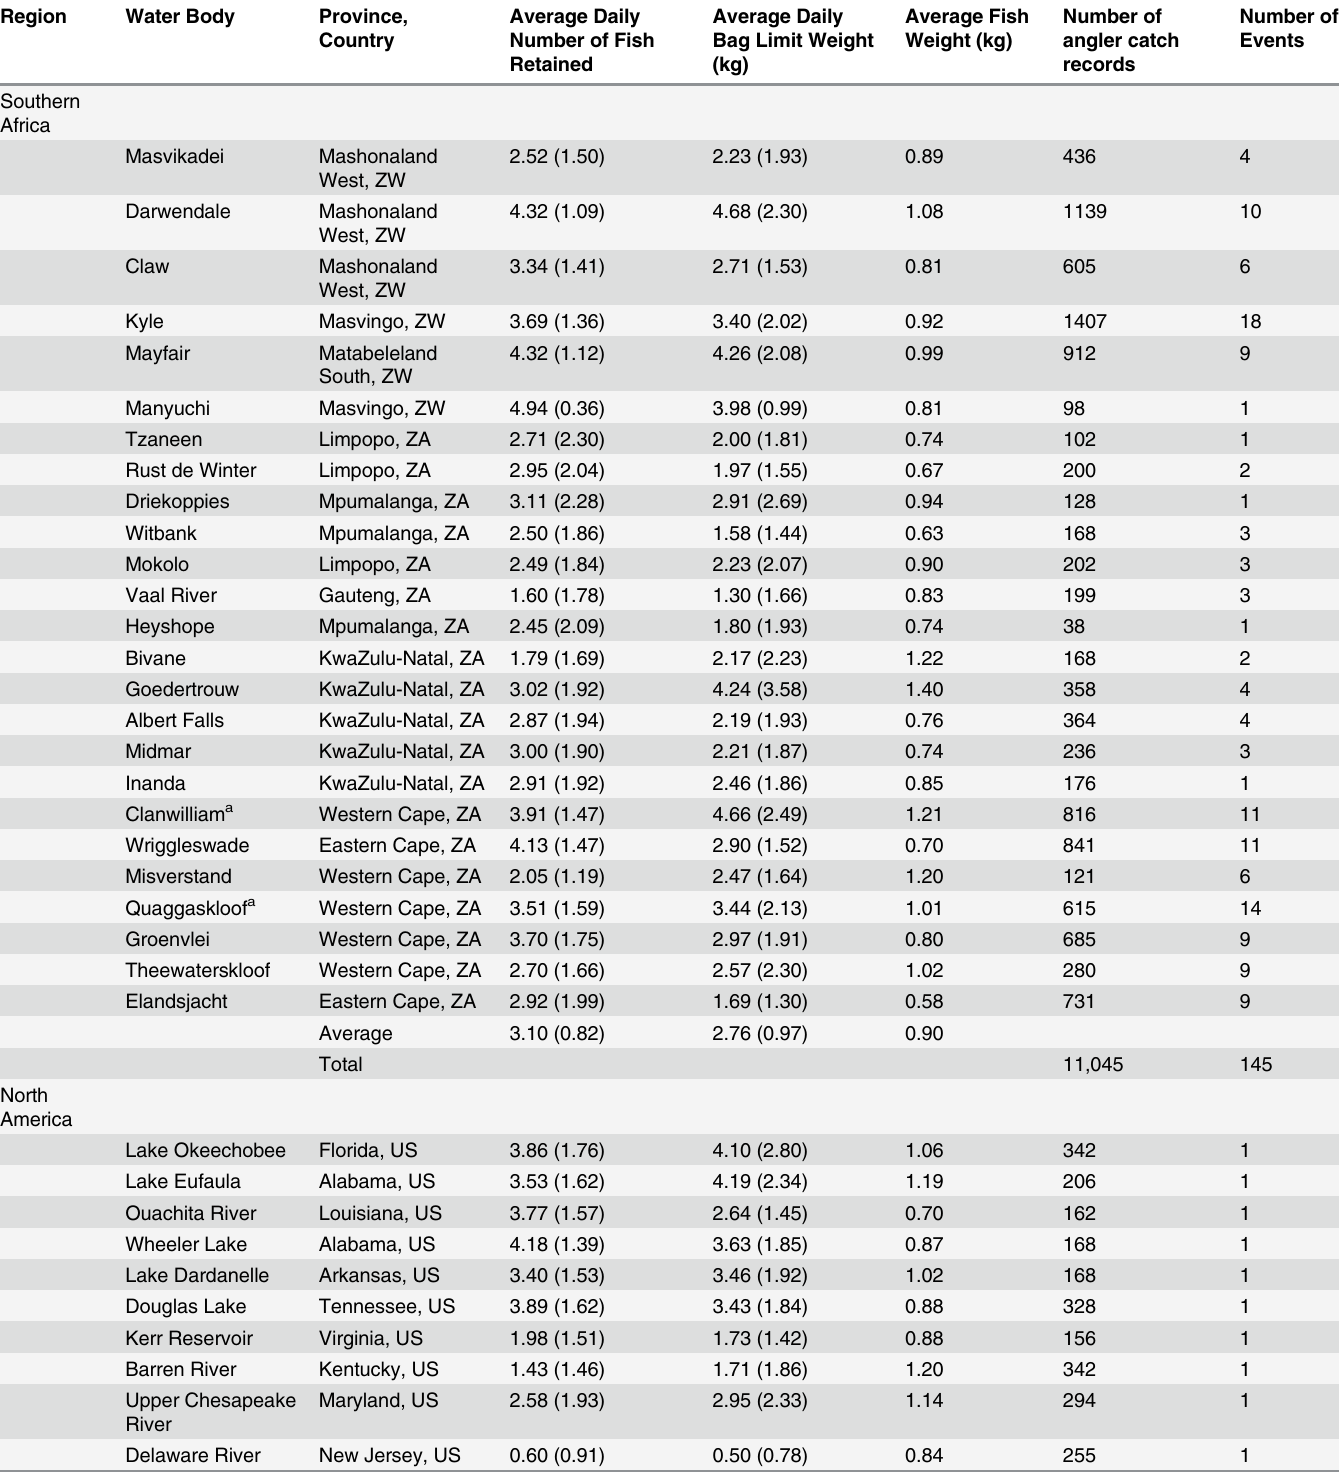
Table 1. A list of B.A.S.S. affiliated tournament angling venues with the associated catch rates and fish weights from water bodies in the intro- duced (southern Africa) and native range (United States) of Micropterus salmoides , M . floridanus , and M . dolomieu . Region Water